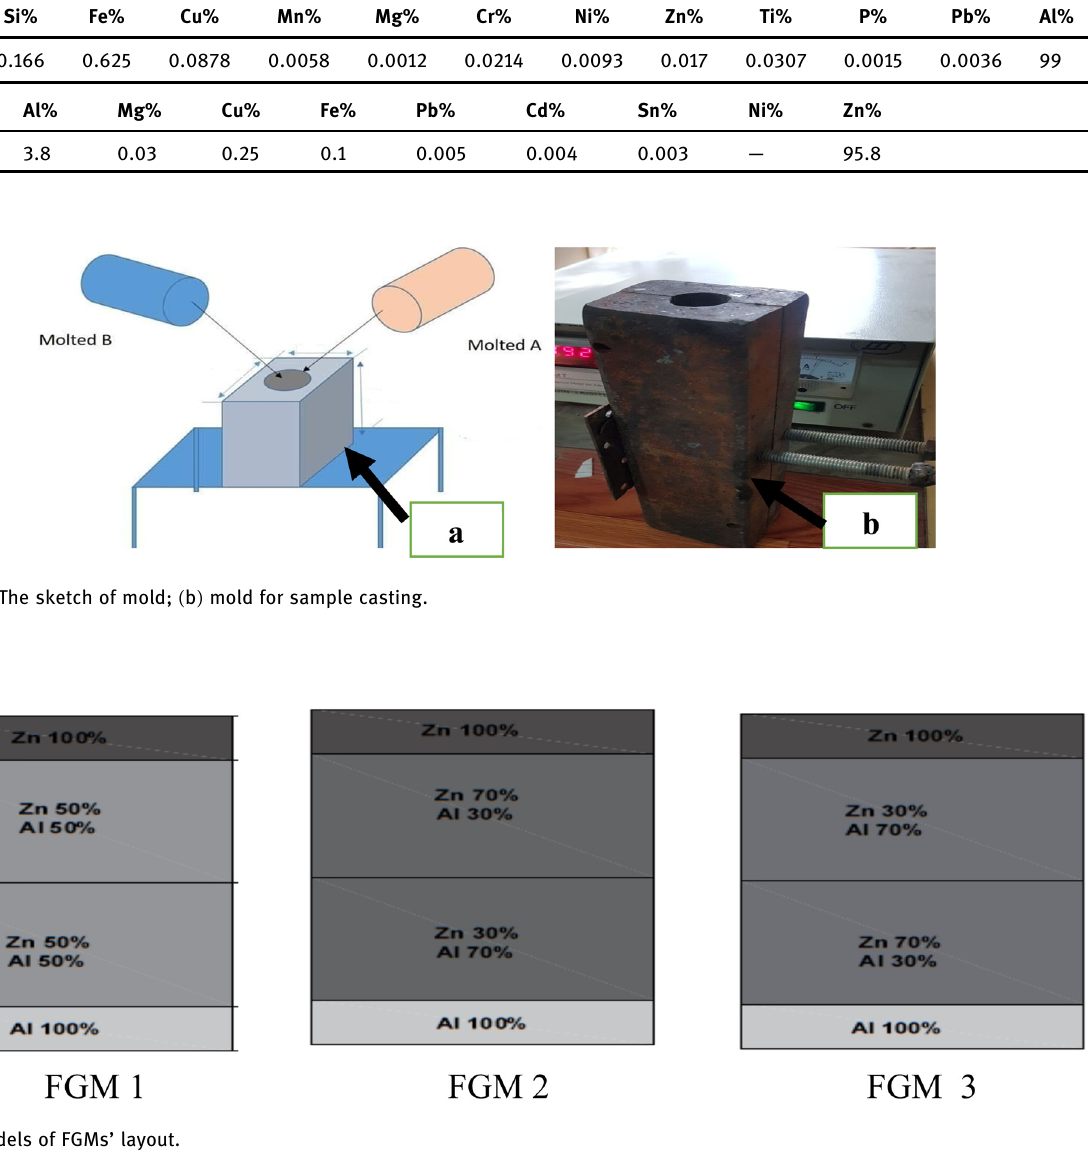
Table 1: Chemical compositions of alloys Alloys